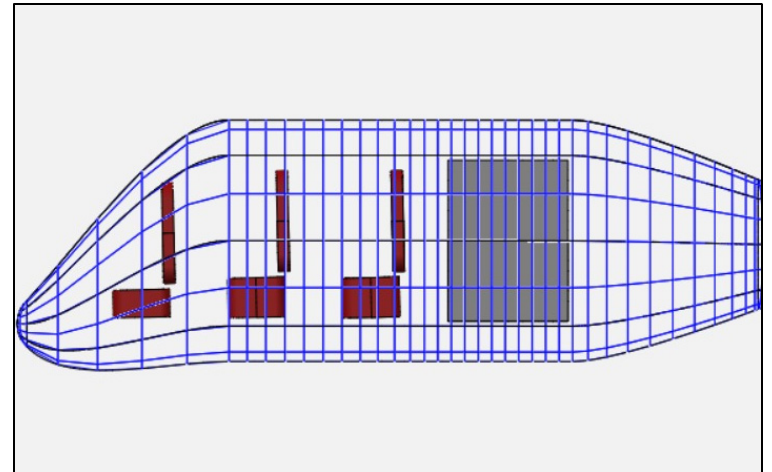
Figure 12. Schematic of cargo compartment volume (air-taxi mode).